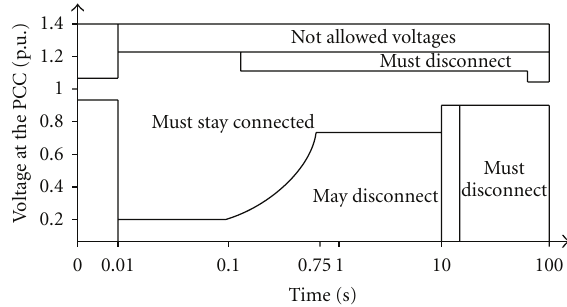
Figure 1: FRT requirements of the Danish grid code for grids below 100 kV